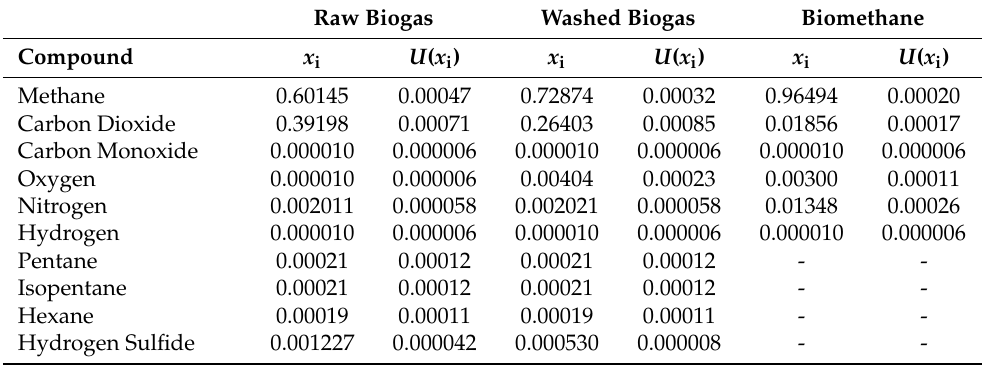
Table 1. Molar composition ( x i ) and expanded ( k = 2) uncertainty ( U ( x i )) of the three samples from the biomethanation plant of the Valdeming ó mez landfill in Madrid